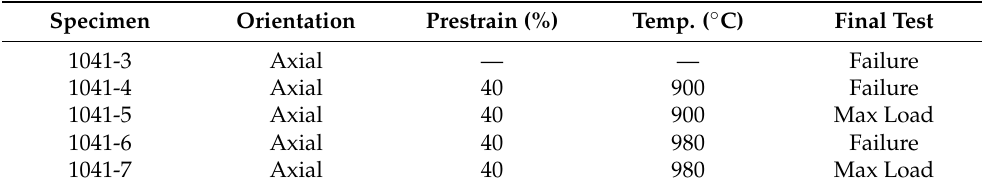
Table 7. The five hourglass specimens used to investigate how heat treatment affected localized